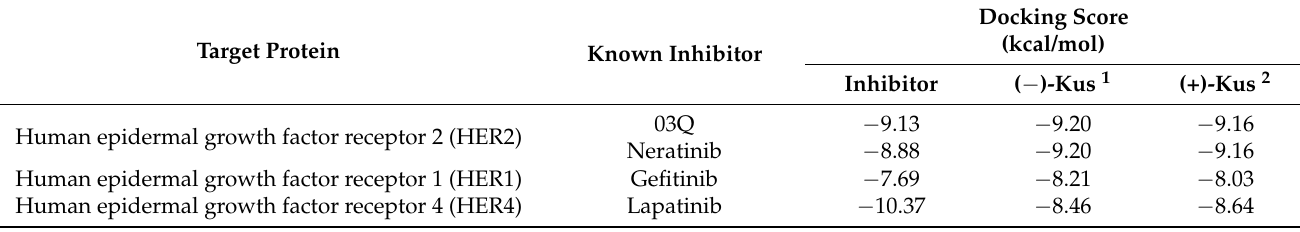
Table 1. Docking score of trans-( ± )-kusunokinin and inhibitor with 10 breast cancer-associated proteins.